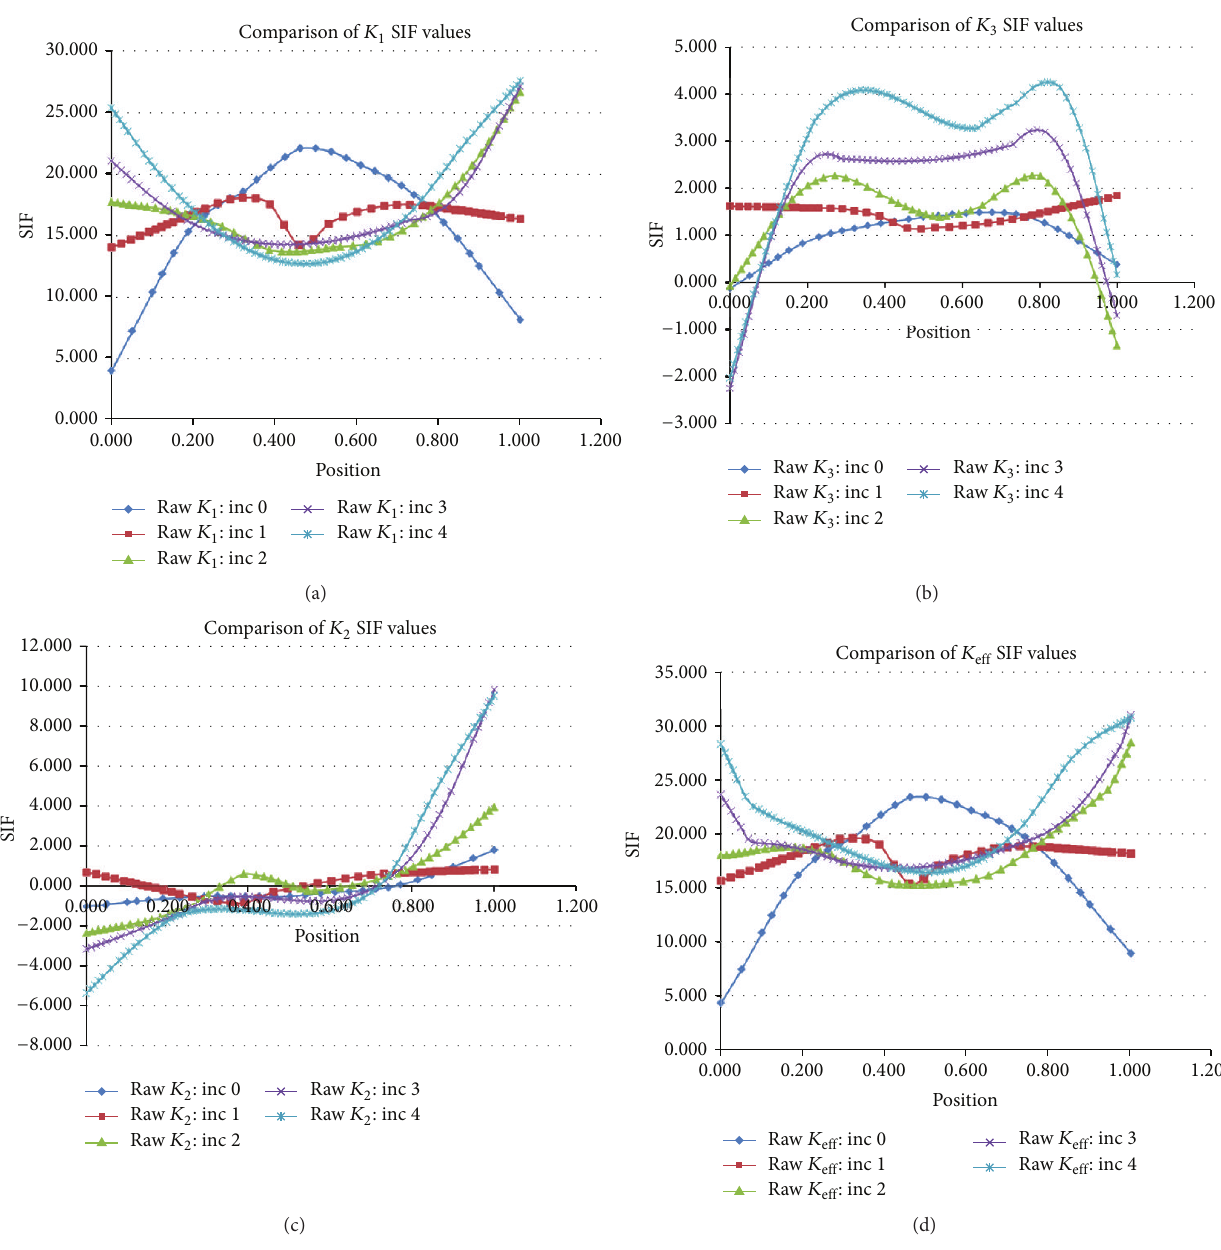
Figure 16: Stress concentration factor of cracks at different growing